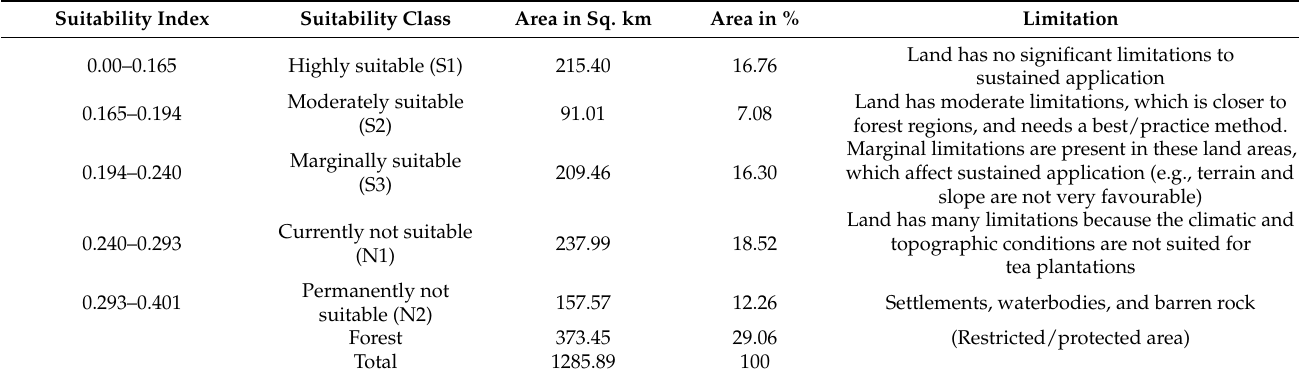
Figure 6. Land suitability for tea plantations. Table 9. Land suitability index and classes for tea plantations.